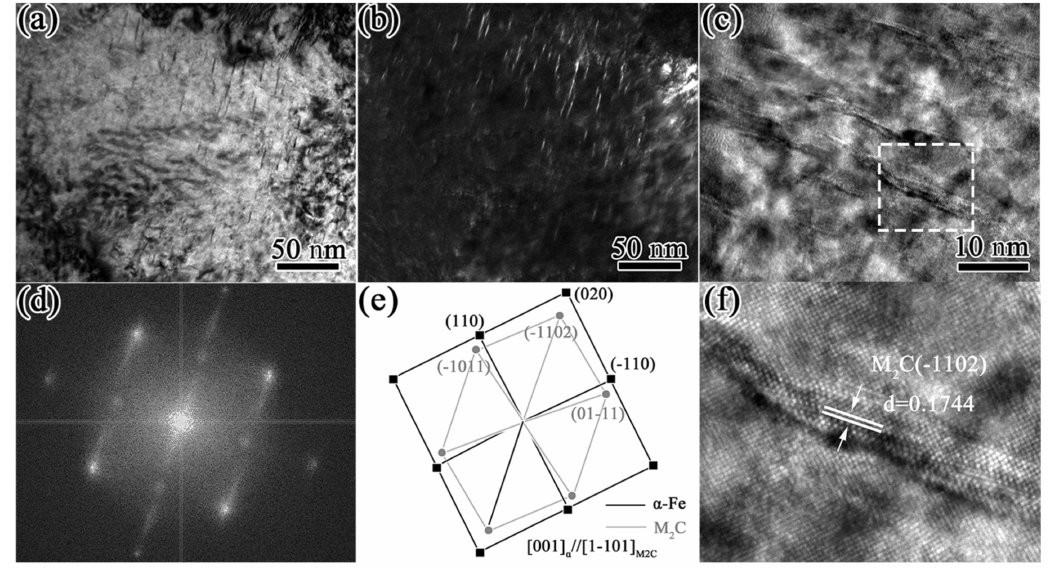
Figure 11. TEM images of short, rod-like precipitates: ( a ) bright field image; ( b ) dark field image; ( c ) high-resolution TEM image. ( d , e ) The Fourier pattern; ( f ) IFFT image of rectangular area in ( c ).